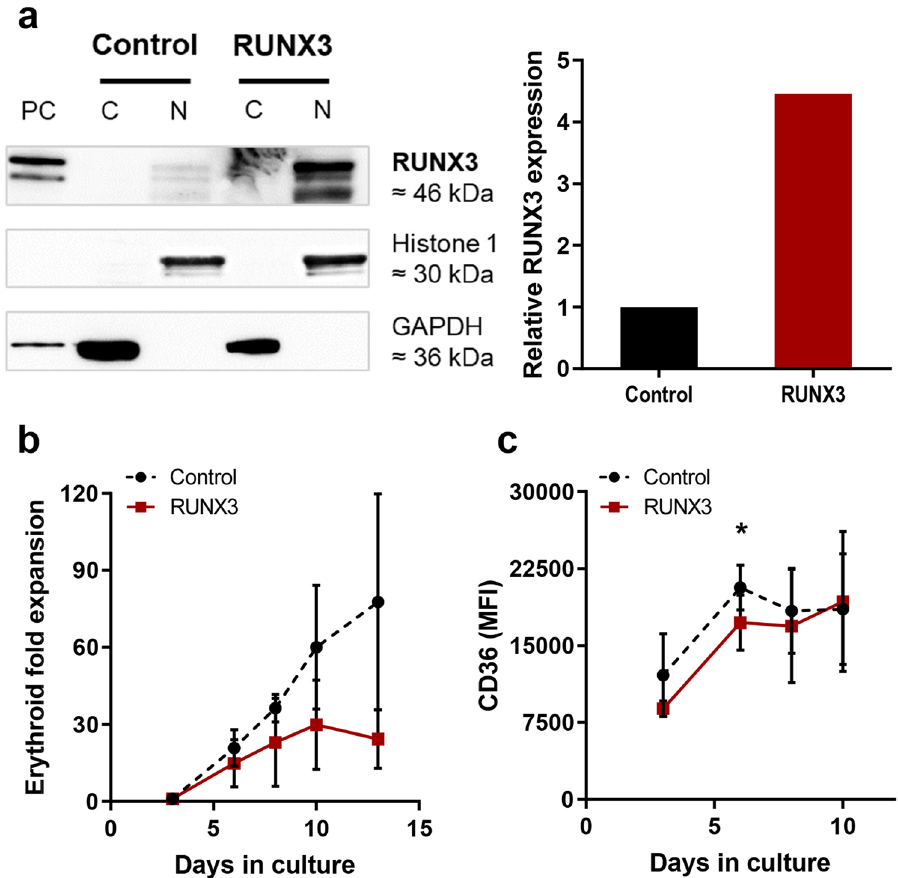
Figure 2. RUNX3 overexpression inhibits CD36 upregulation and proliferation in HSPC during erythropoieitin (EPO) independent erythroid differentiation. ( a ) Left Panel: Western blot showing RUNX3 protein levels in the cytosol and nucleus of control and RUNX3 CD34 + HSPC (day 6 of culture). Phoenix packaging cells overexpressing RUNX3 were used as a positive control and Histone 1/GAPDH were used as loading controls. PC—Positive control; C—Cytosol; N—Nucleus. Same membranes were reprobed for Histone H1 and GADPH. Full length blots are included in Supplemental Fig. S3. Right panel : Relative RUNX3 nuclear expression in control and RUNX3 HSPC cells (day 6 of culture) normalised to control. ( b ) Cumulative fold expansion of CD13 low CD36 high erythroid committed cells during the EPO independent phase of growth. Data indicate mean ± 1SD (n ≥ 3). ( c ) Summary data of CD36 mean fluorescence intensity (MFI) in CD13 low CD36 high erythroid committed cells over time. Data indicate mean ± 1SD (n ≥ 3). Significant difference of RUNX3- expressing cells from controls was analysed by paired t-test, * p <